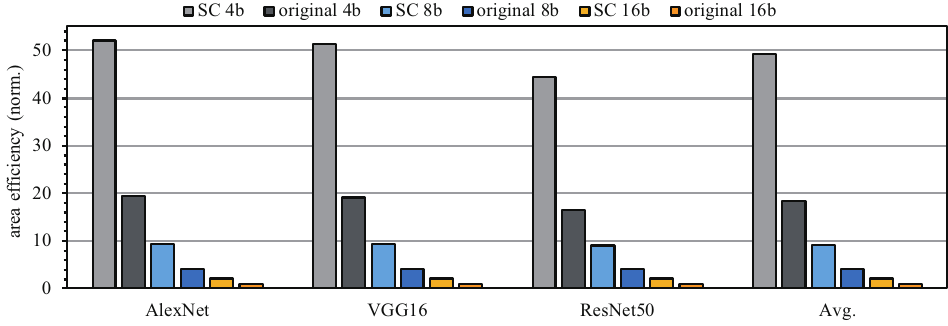
Figure 17. Area efficiency comparison for different bit widths with different networks.